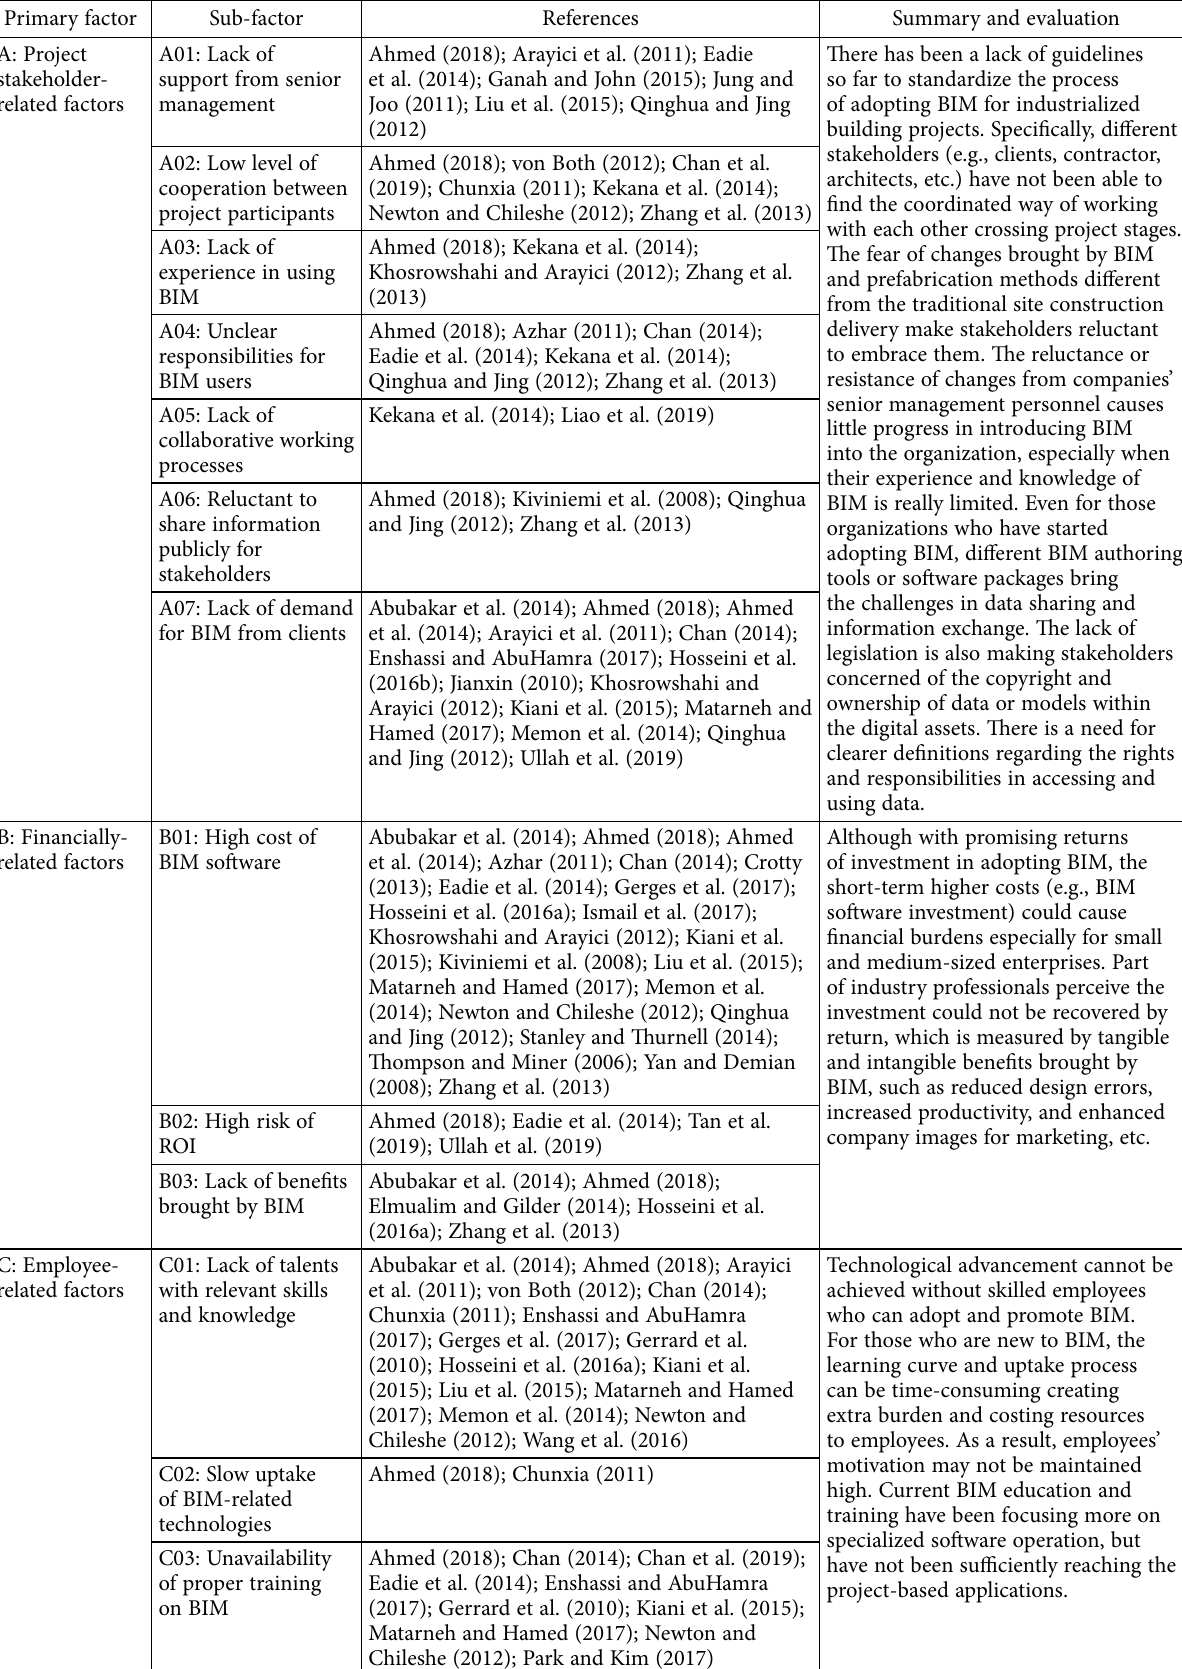
Table 1. Identification and classification of potential barrier